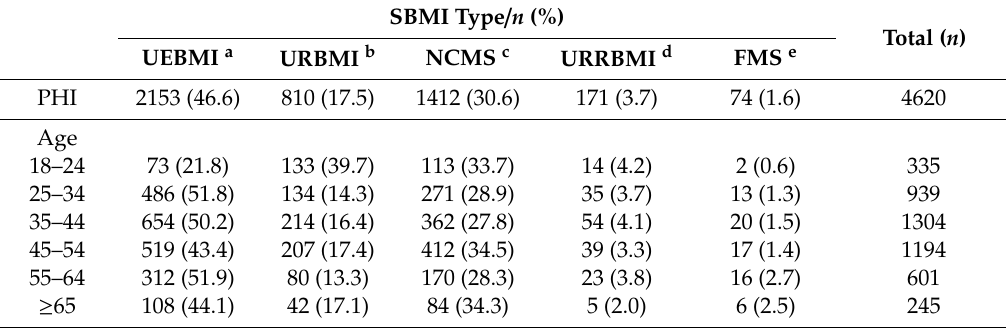
Table 3. Information on individuals with both PHI and SBMI in di ff erent age